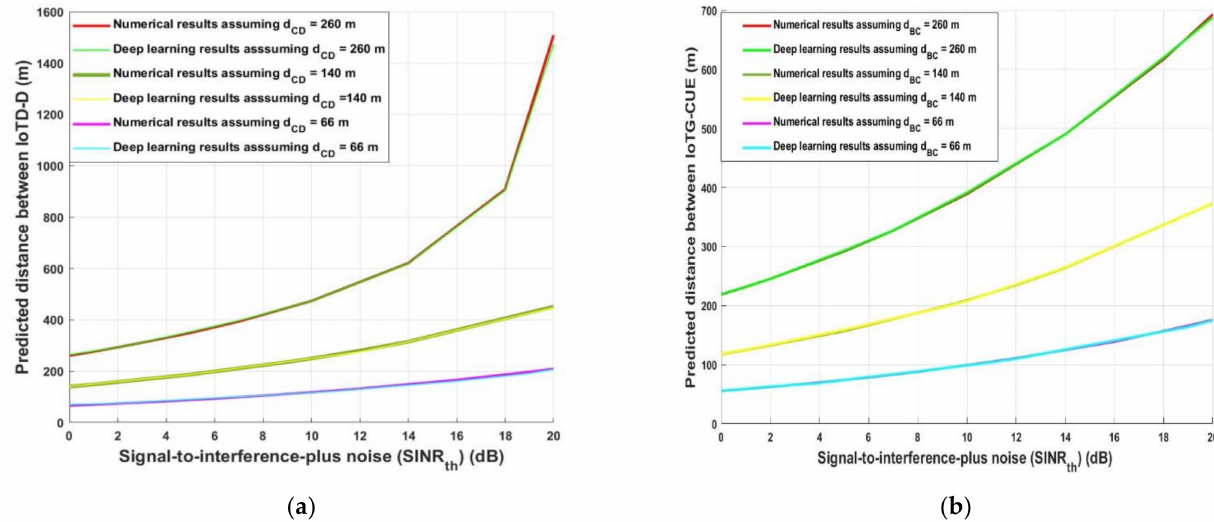
Figure 7. ( a ) Signal-to-interference-ratio- plus-noise ( SINR th ) versus predicted distance between IoTD-D (uplink) ( b ) Signal-to-interference-ratio- plus-noise ( SINR th ) versus predicted distance between IoTG-CUE